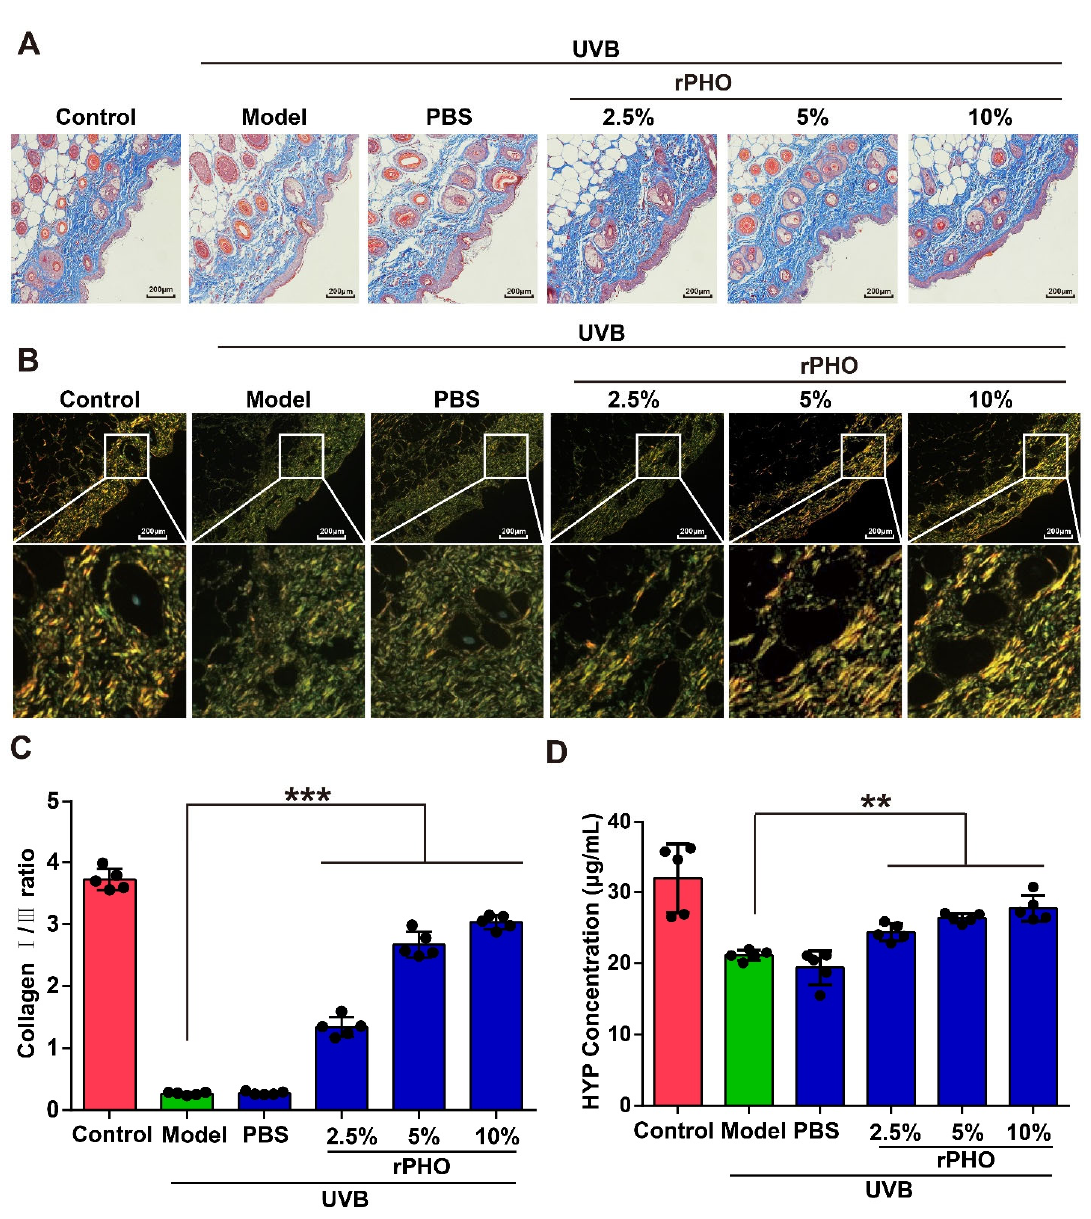
Figure 5. Photolyase inhibited UVB-induced reduction in collagen. ( A ) Masson staining; blue represents collagen fibers. ( B ) Representative picrosirius red staining of the dorsal skin. Images were obtained by polarized light microscopy. Type-I collagen: strong orange-yellow or bright red; type-III collagen: green. Scale bar = 200 µ m. ( C ) The percentages of type-I and type-III collagen were calculated using ImageJ. ( D ) Hydroxyproline (HYP) in the dorsal skin was quantified. Data are shown as means ± SD ( n = 5). ** p < 0.01, *** p < 0.001.